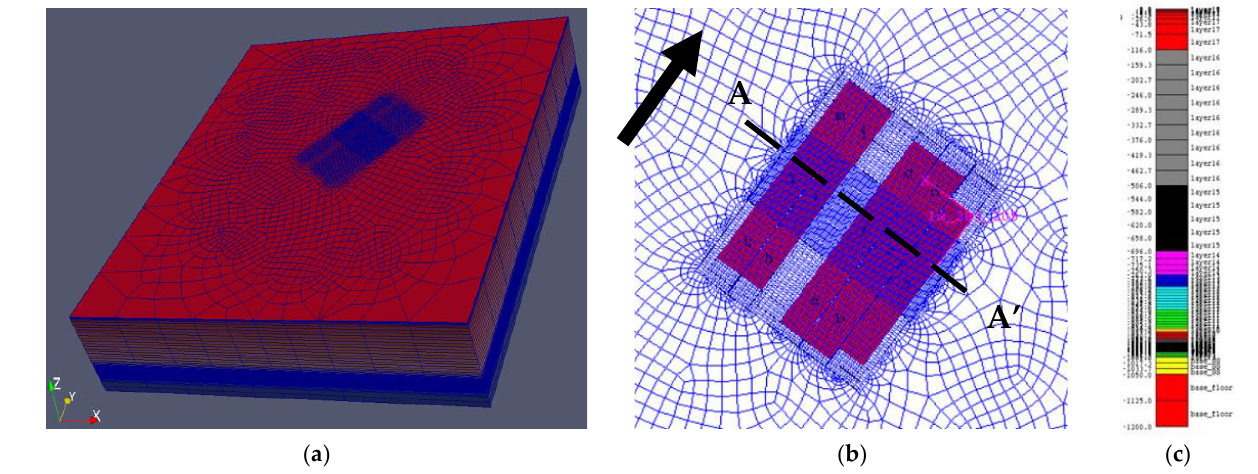
Figure 2. ( a ) A 3D view of the model and a plan view of the COSFLOW finite-element mesh. The vertical direction has been exaggerated by a factor of 10. ( b ) The blue lines show the finite-element mesh, which is coarse at the model boundaries and very fine around and above the panels. The cross-section AA’ shows the subsidence measurement line on the model. A snapshot of gradually varying mesh along the vertical direction is shown in ( c ). Table 1. Quantities defining the panel geometry.